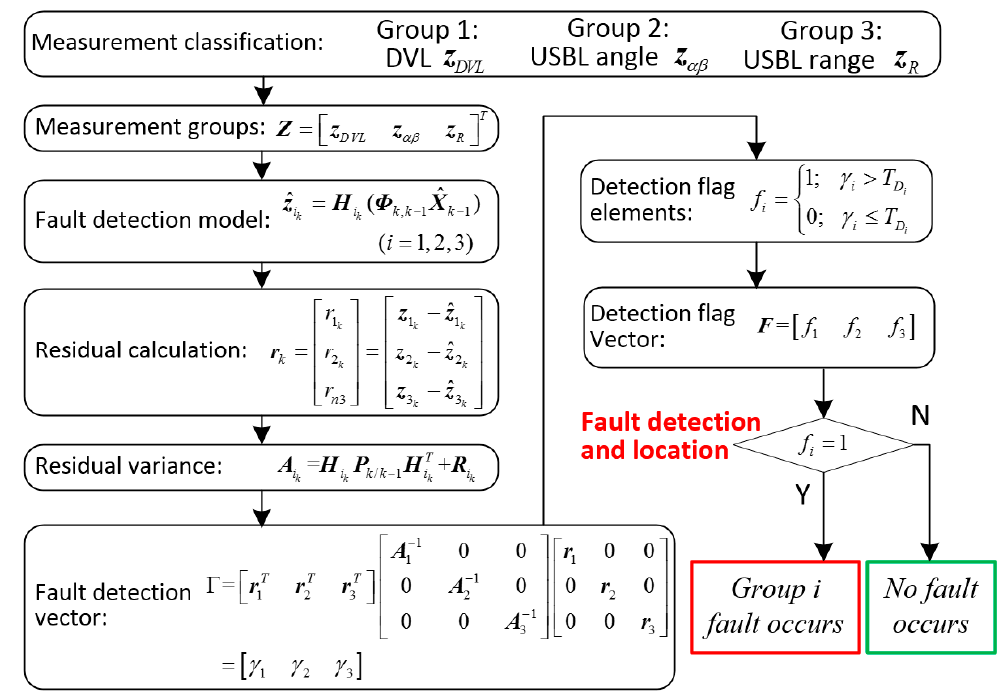
Figure 4. The flow diagram of the vector fault detection method.